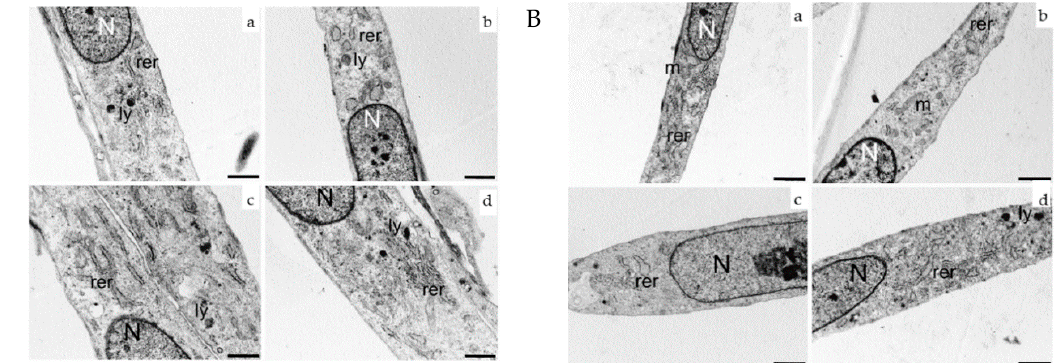
Figure 3. Ultrastructural analysis of HDF cells exposed to 2.45 GHz. ( Panel A ): sham ( a , c ) and 2.45 GHz CW- ( b , d ) exposed HDF. Exposed cells were examined 2 h ( b ) and 24 h ( d ) after exposure. Nucleus (N), rough endoplasmic reticulum (rer), lysosome (ly), mitochondria (m) (bars correspond to 1 µm). No morphological differences were found between sham or exposed cells. ( Panel B ): sham ( a , c ) and 2.45 GHz PW- ( b , d ) exposed HDF. Exposed cells were examined 2 h ( b ) and 24 h ( d ) after exposure. (Bars correspond to 1 µm). No morphological differences were found between sham and exposed cells.